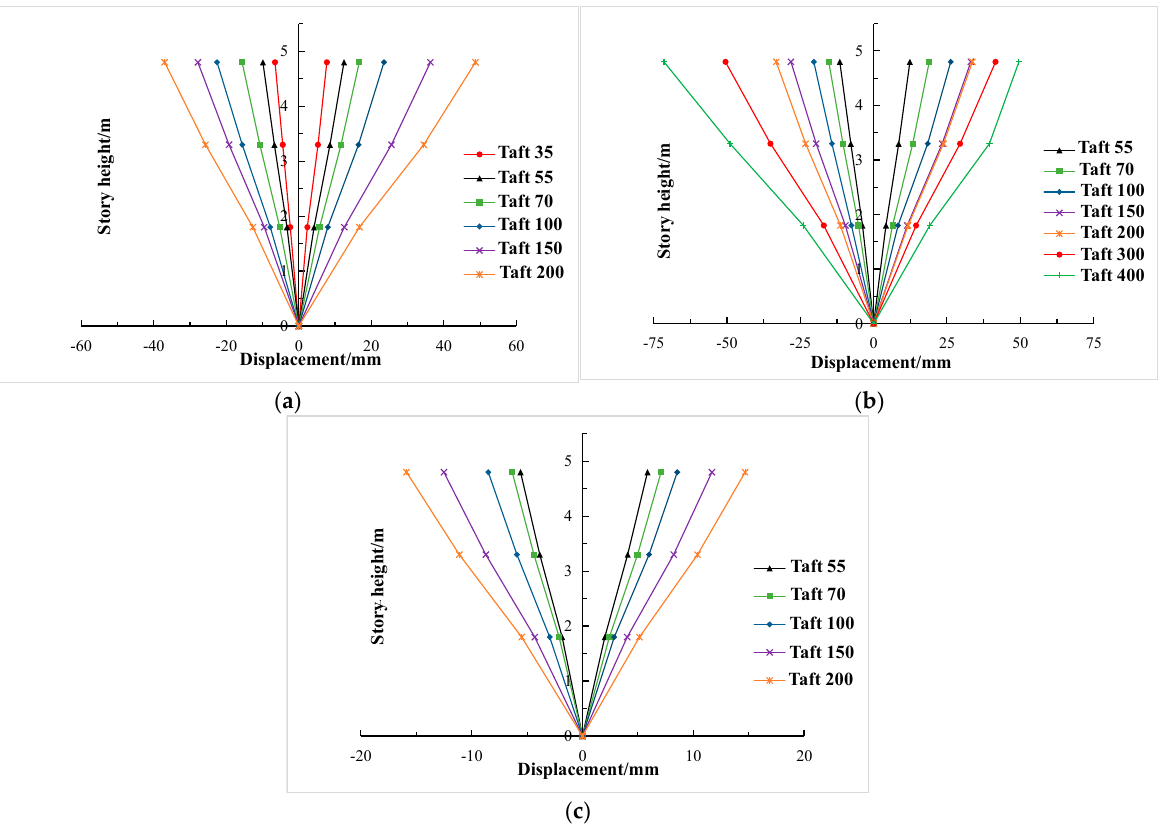
Figure 17. Envelope diagram of displacement response along height. ( a ) El Centro wave; ( b ) Taft wave; ( c ) Lanzhou artificial wave.